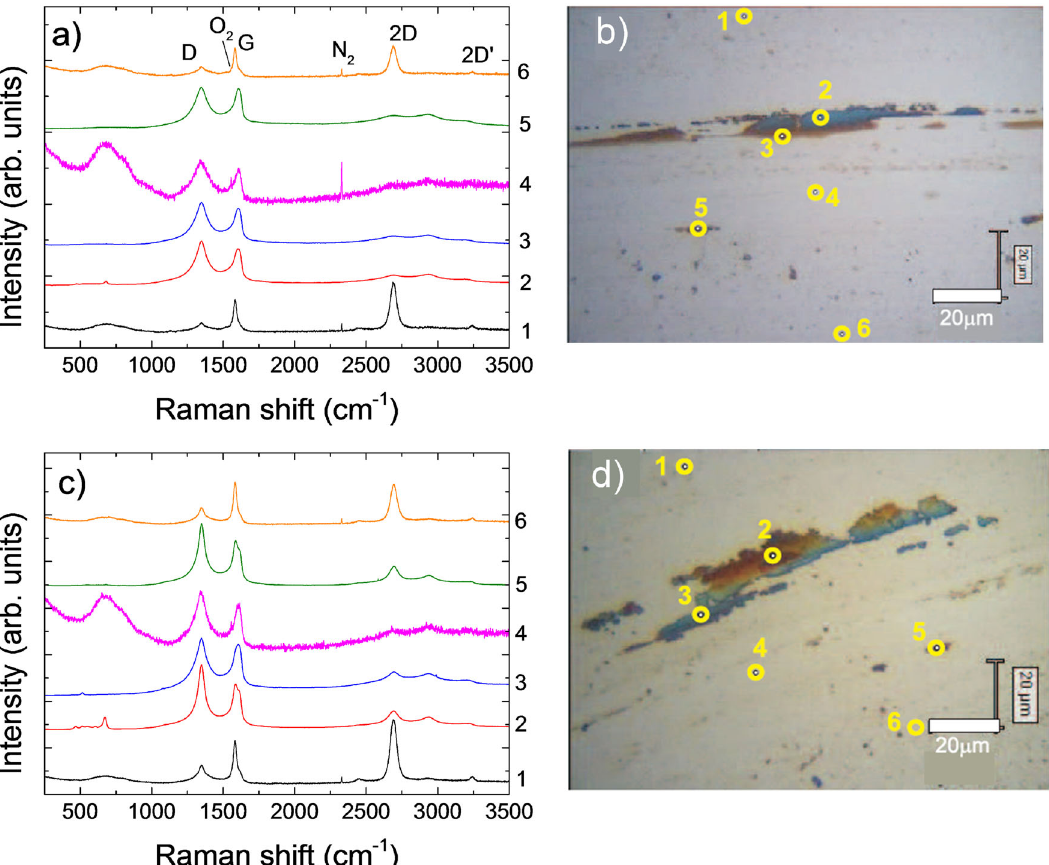
Fig. 6 Raman measurements across wear tracks. Raman spectra, normalized to I (G), recorded across wear tracks of ( a ) 3LG and ( c ) 4LG and corresponding optical pictures in ( b ) and ( d ). In ( b ), ( d ) The Raman spectra are recorded across the wear tracks at the positions indicated by the yellow circles to compare graphene before and after friction and wear tests. The colors of the traces are due to a mixture of graphene, HDM components, and polymer residues coming from graphene